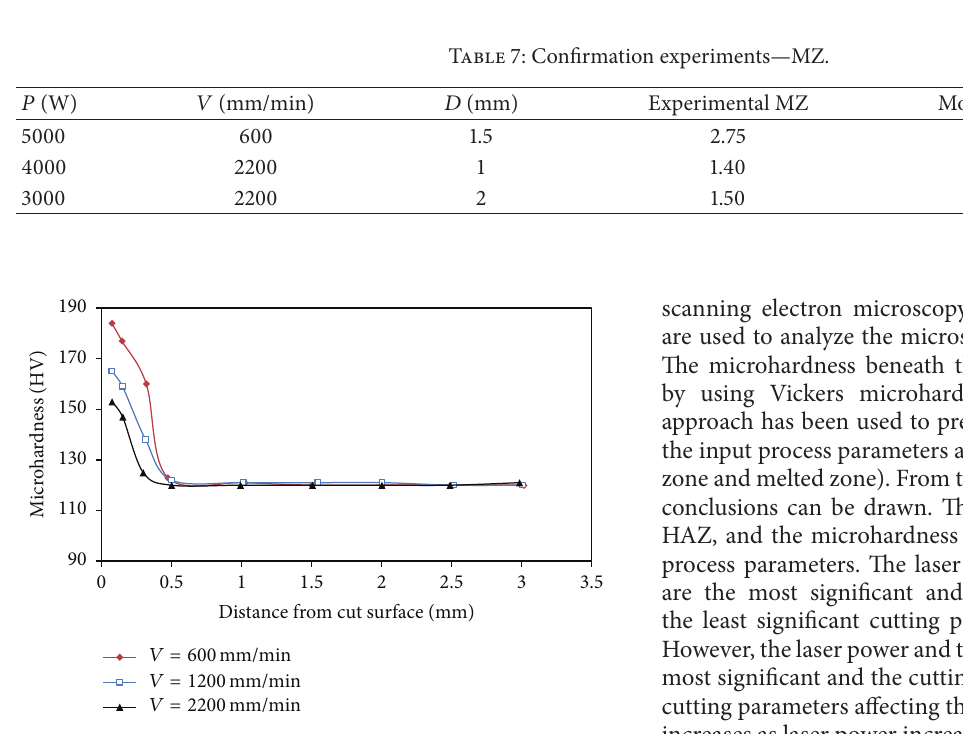
Figure 16: Effect of cutting speed on HAZ microhardness.